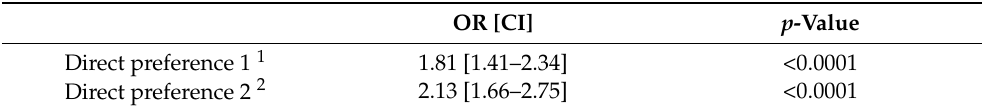
Table 4. Association between Nutri-Score and the probability of preferring the FoPL the participant was mainly exposed to ( n =